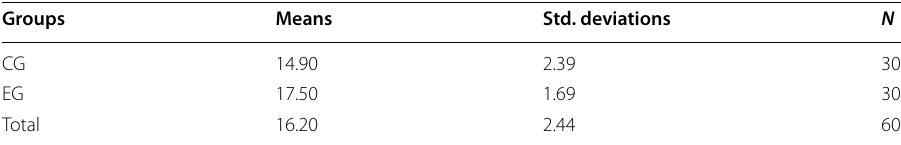
Table 1 EG and CG (VL post-tests) Groups